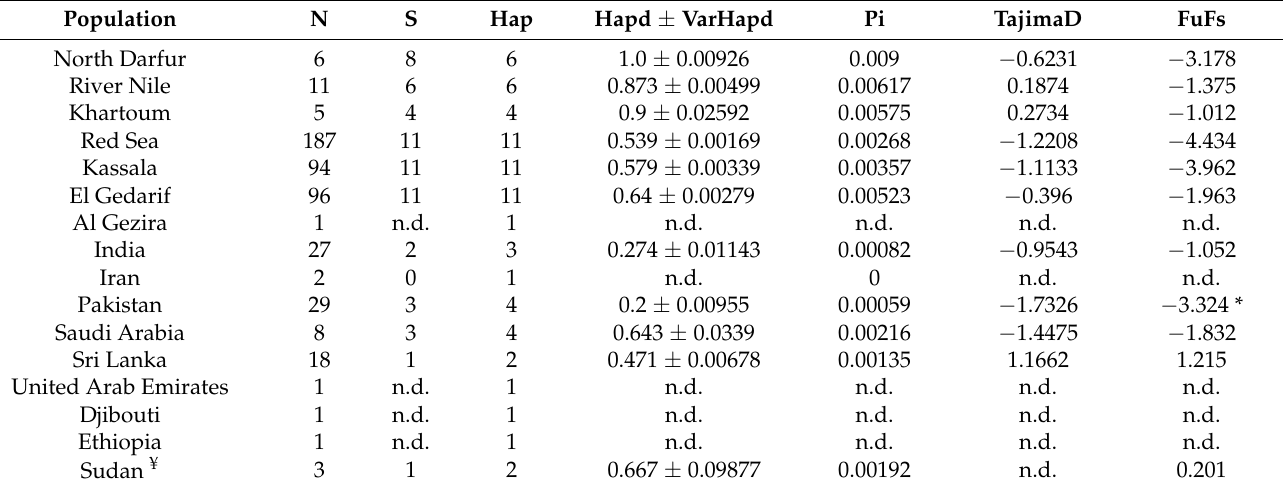
Table 2. Diversity and neutrality indices for An. stephensi populations calculated from the nucleotide data set of the mitochondrial cytochrome c oxidase 1 (CO1)